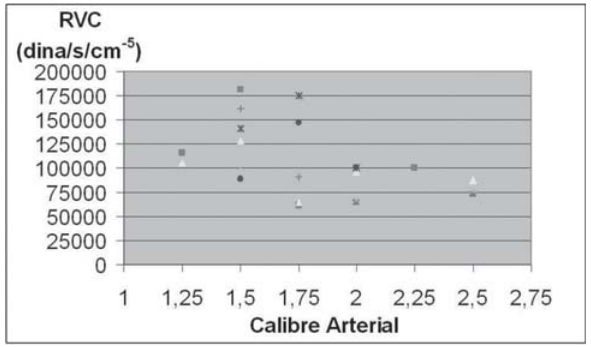
Fig. 4 - Estudo dos casos. Relação entre calibre arterial e RVC. Note que a variabilidade da RVC não se apresenta diretamente proporcional com o calibre. RVC = resistência vascular